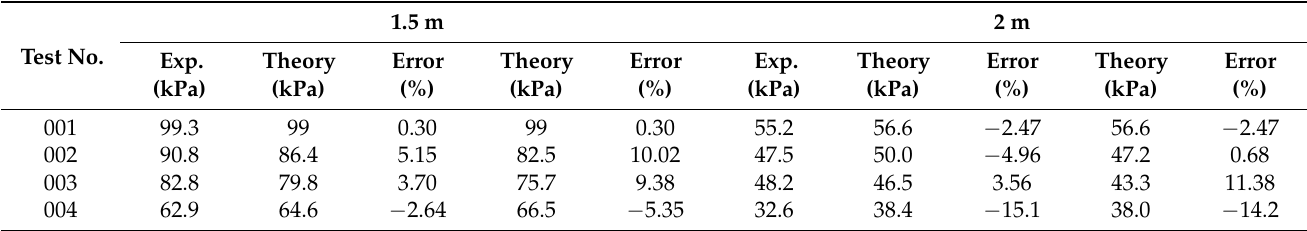
Table 5. Comparison between the theoretical calculation and experimental measurement of peak overpressure under different α m